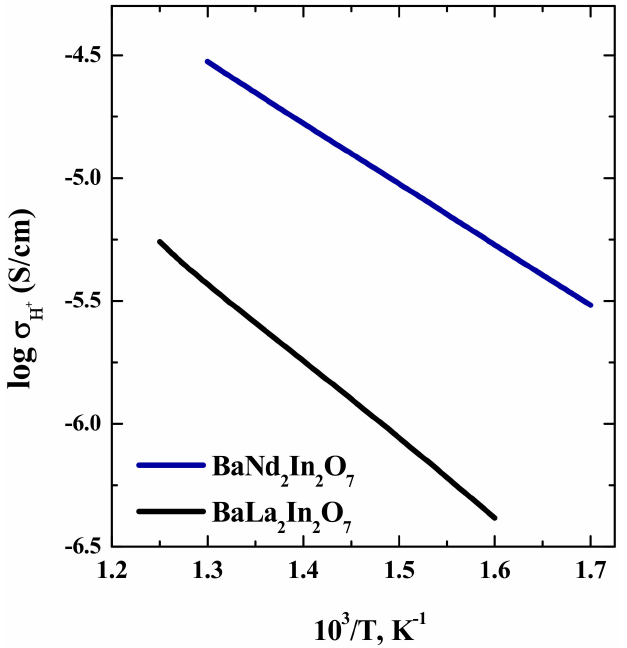
Figure 9. Temperature dependencies of protonic conductivity for BaNd 2 In 2 O 7 (blue line) and BaLa 2 In 2 O 7 (black